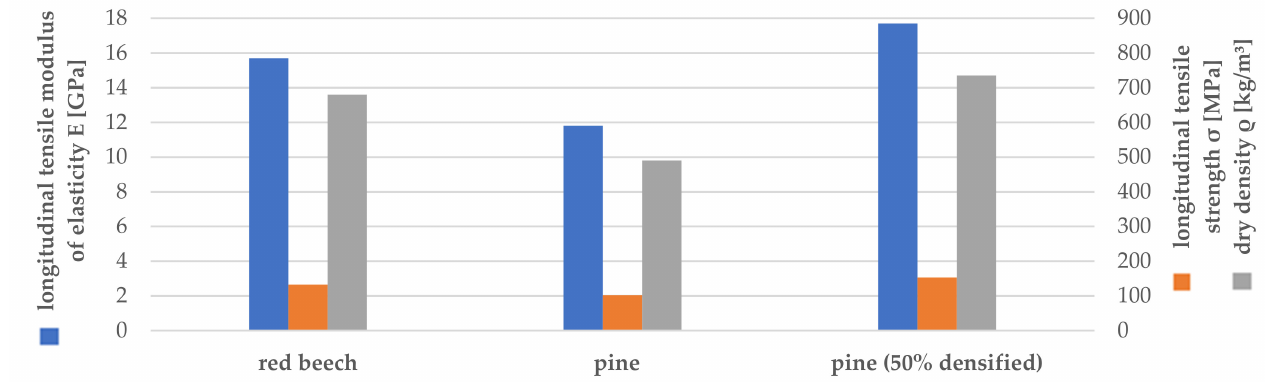
Figure 1. Average tensile modulus of elasticity, tensile strength and density for solid wood of red beech and pine as well as a hypothetical estimate for 50% compressed pine